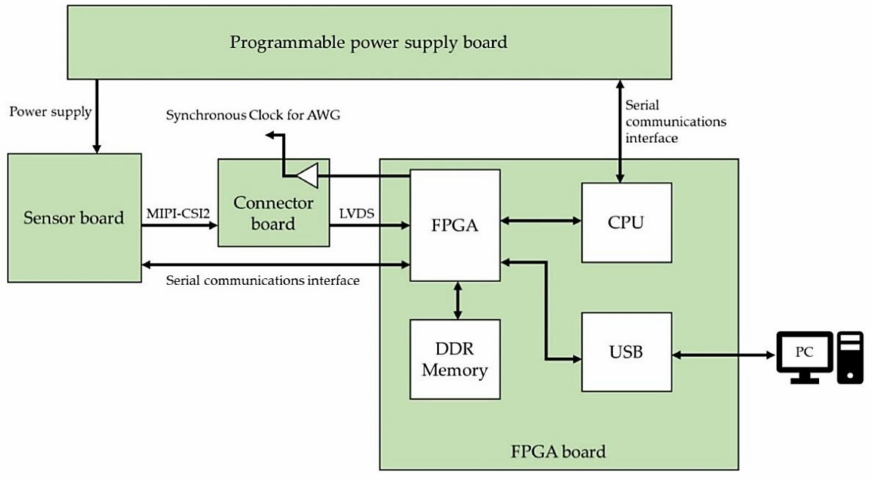
Figure 10. System overview.